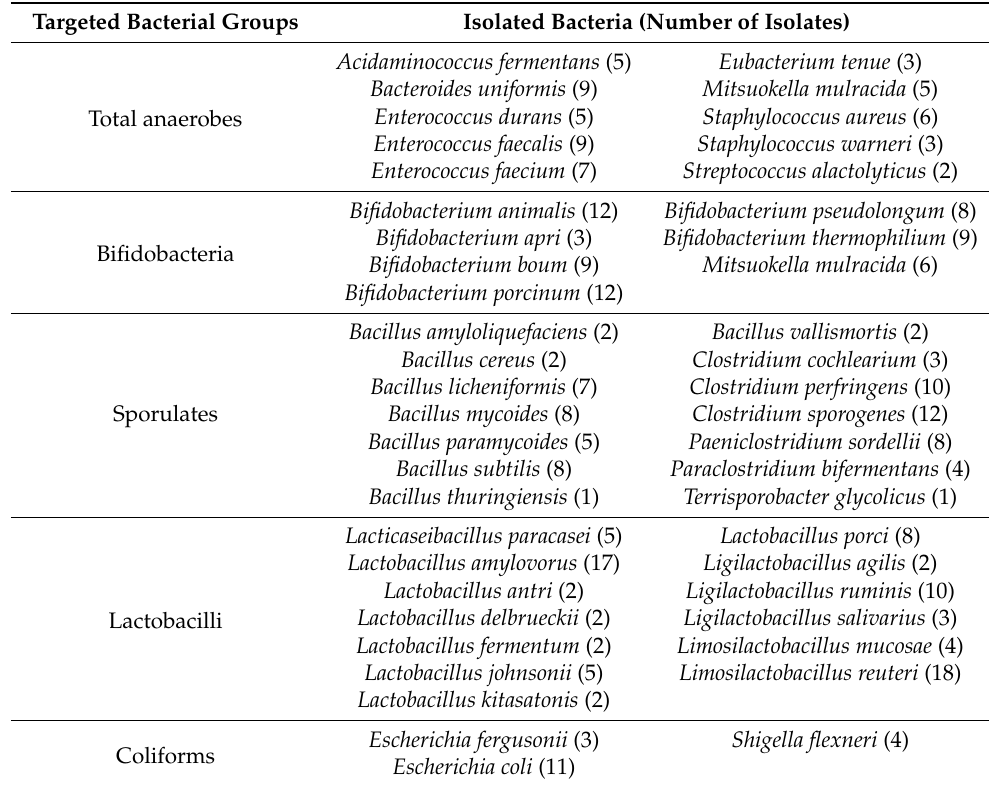
Table 2. Bacterial species isolated from colon and fecal samples of pigs and piglets. Targeted Bacterial Groups Isolated Bacteria (Number of